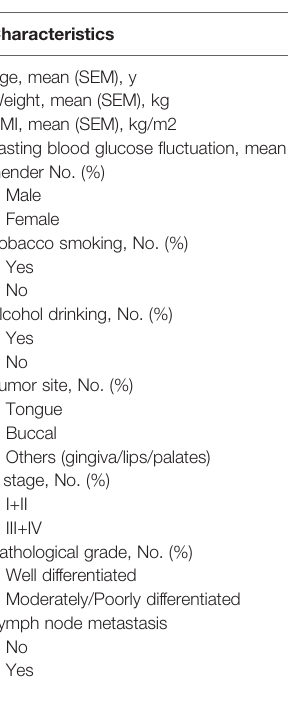
TABLE 1 | Patient and tumor